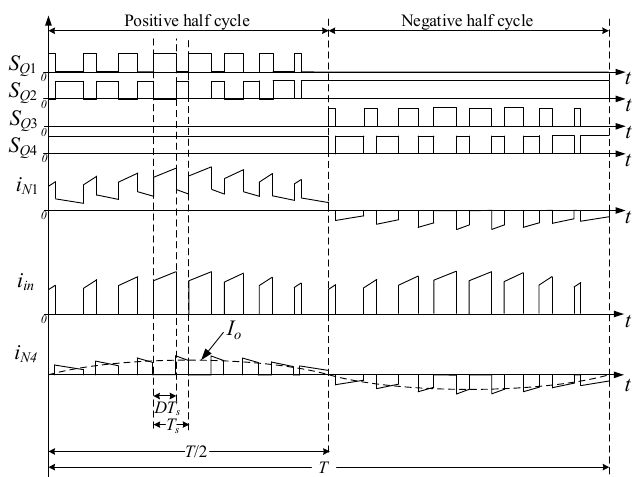
Figure 5. Illustration of key waveforms of the proposed SSBBI.